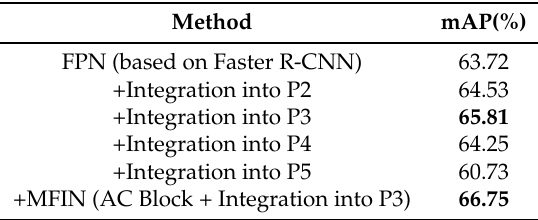
Table 3. Different integration manners of the multi-scale feature maps for Multi-Scale Feature Integration Network